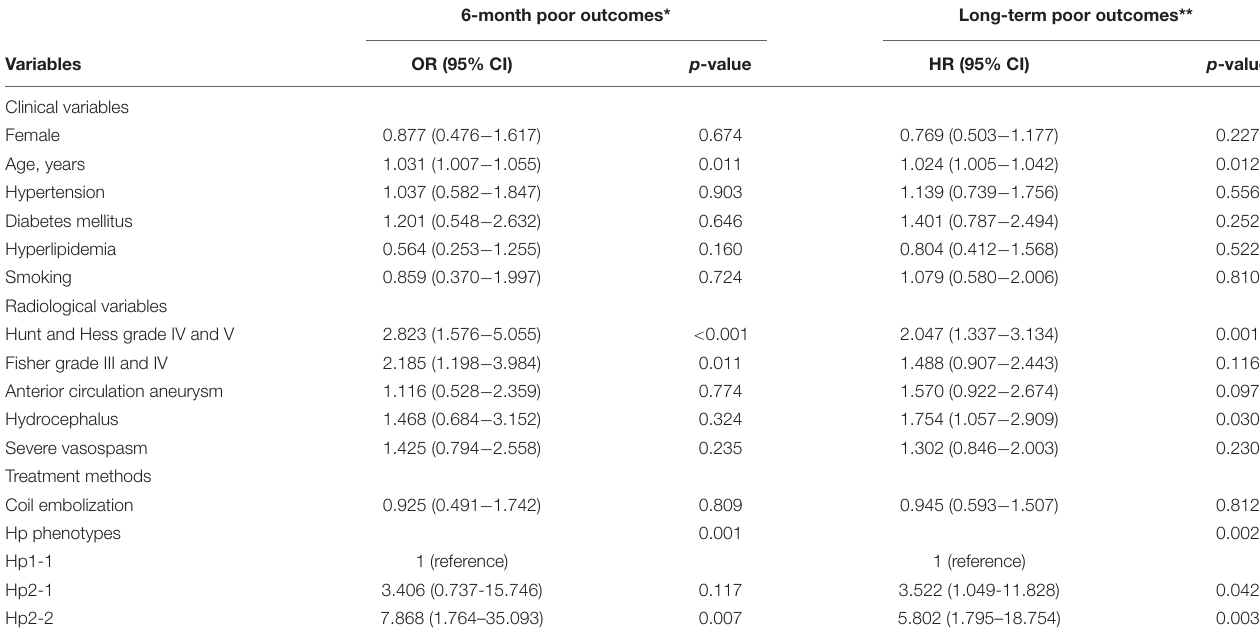
TABLE 2 | Multivariable logistic regression analysis of factors associated with 6-month poor outcomes and Cox proportional-hazards regression analysis of long-term poor outcomes following subarachnoid